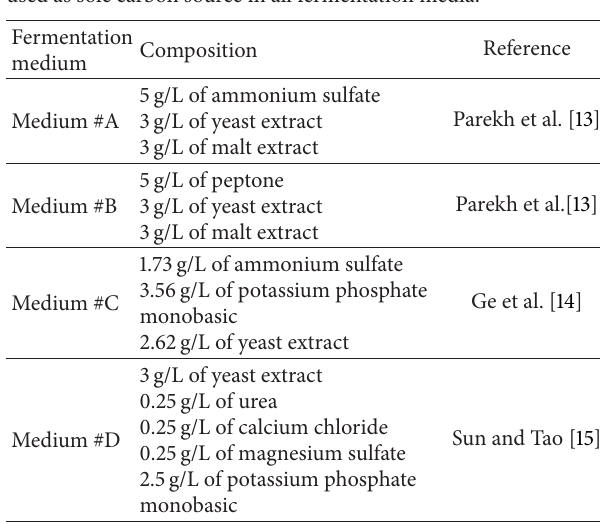
Table 1: Medium composition for the fermentation of S. shehatae UFMG-HM 52.2 for ethanol production. Nutrients were added to detoxified hemicellulosic sugarcane bagasse hydrolysate that was used as sole carbon source in all fermentation media.